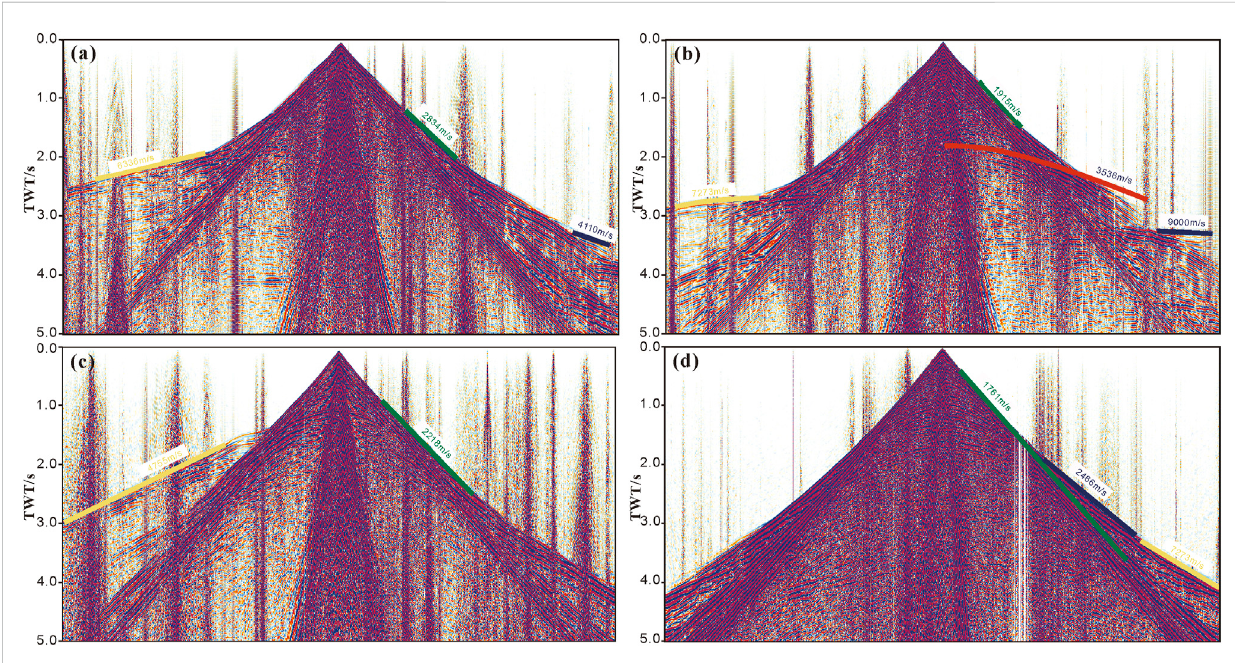
FIGURE 6 Fourshotrecordswiththemarkofvelocityofthe fi rst-arrivalwave. (A) Shotnumber:1885.5 (B) Shotnumber:2077.5 (C) Shotnumber:3857.5 (D) Shot number:4879.5. The locations of shot records are marked by yellow stars in Figure